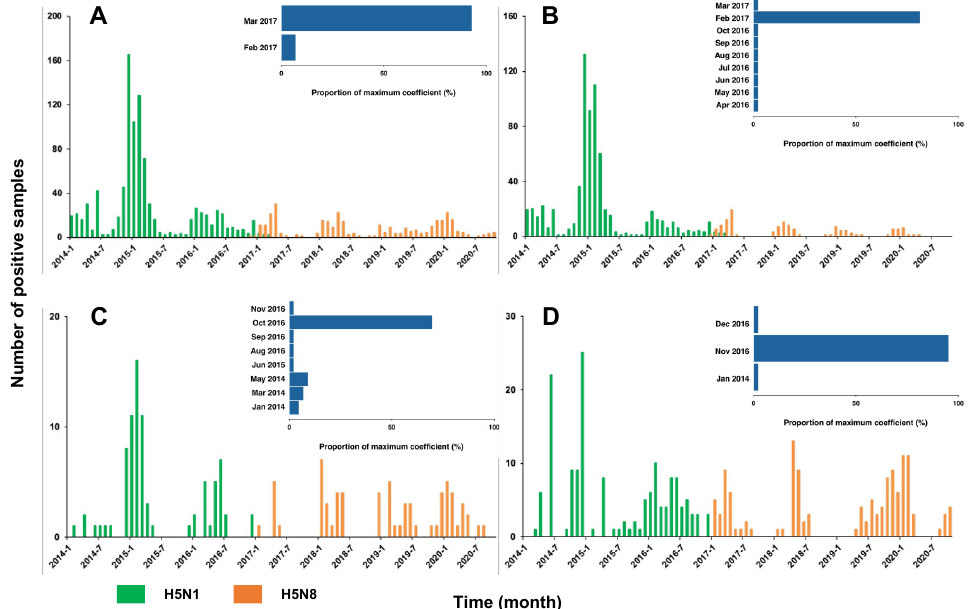
Figure 2. Numbers of positive HPAI H5N1 vs. HAPI H5N8 cases in Egypt 2014–2020. ( A ) Overall, ( B ) backyards, ( C ) farms, and ( D ) LBMs. The insets show the distribution of the timing for the maximum correlation of two subtypes.